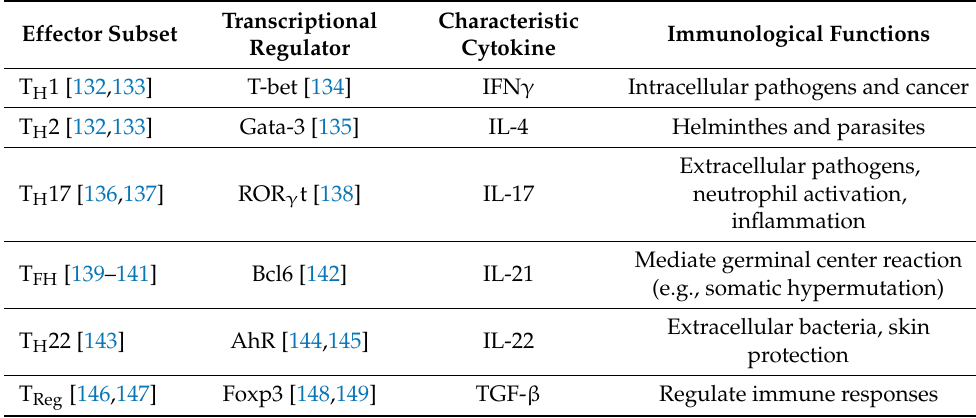
Table 1. CD4 + T cell effector